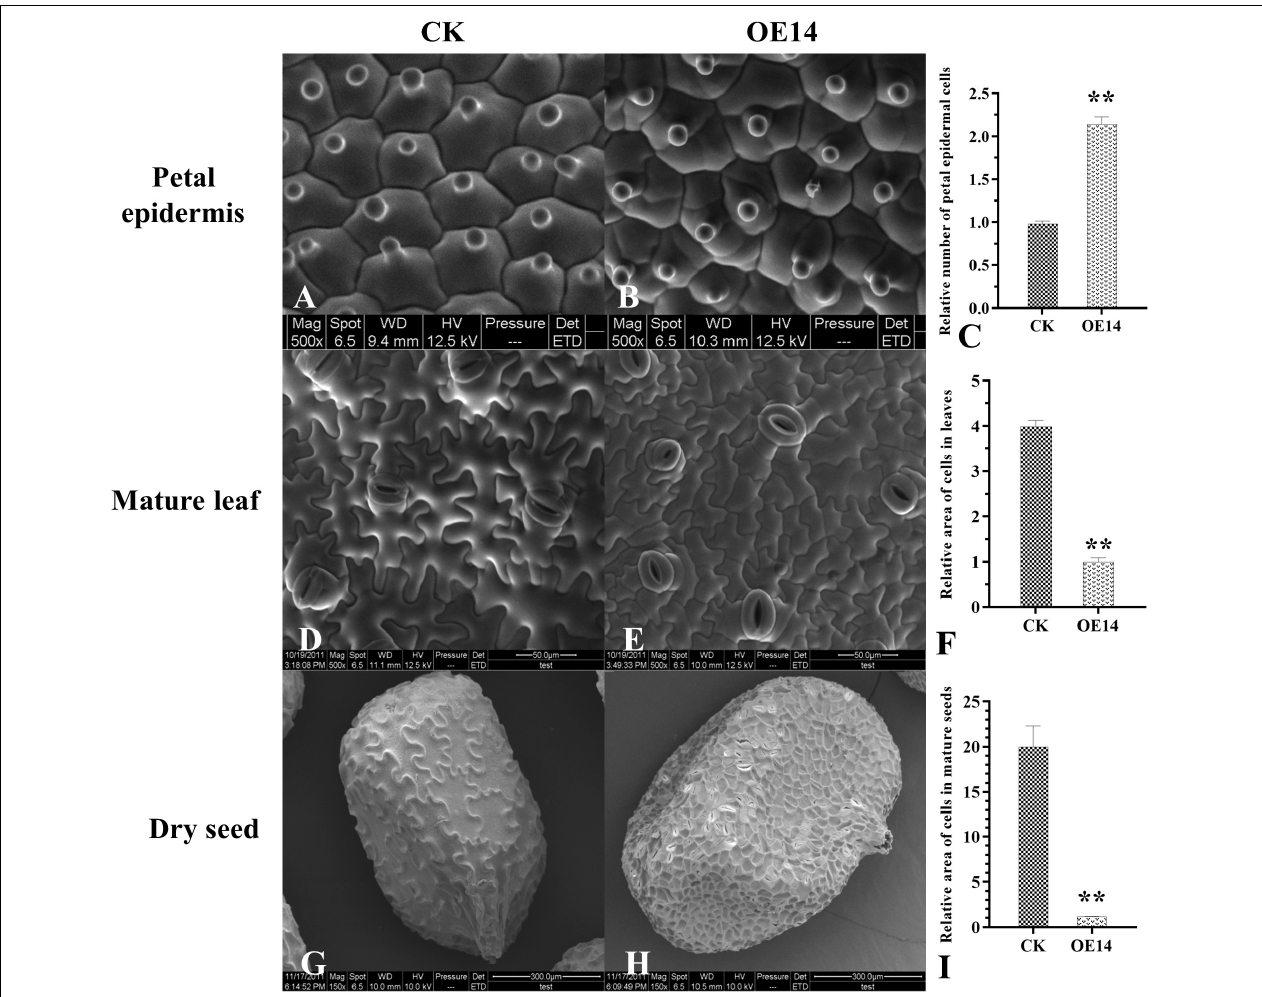
FIGURE 6 | Comparative analysis of cell size between CK and transgenic (OE14) tobacco by environmental scanning electron microscope (ESEM). (A,B) ESEM observation of the petal epidermis between CK and transgenic (OE14) line. (D,E) ESEM observation of the abaxial epidermis of the leaves between CK and transgenic (OE14) line. (G,H) Microscopic observation of dry seeds between CK and transgenic (OE14) line. (C,F,I) Statistical analysis of the petal epidermis, mature leaf, and seed coat cells between CK and transgenic (OE14) lines. Asterisks on the column diagram showed the significant difference between different samples ( p <